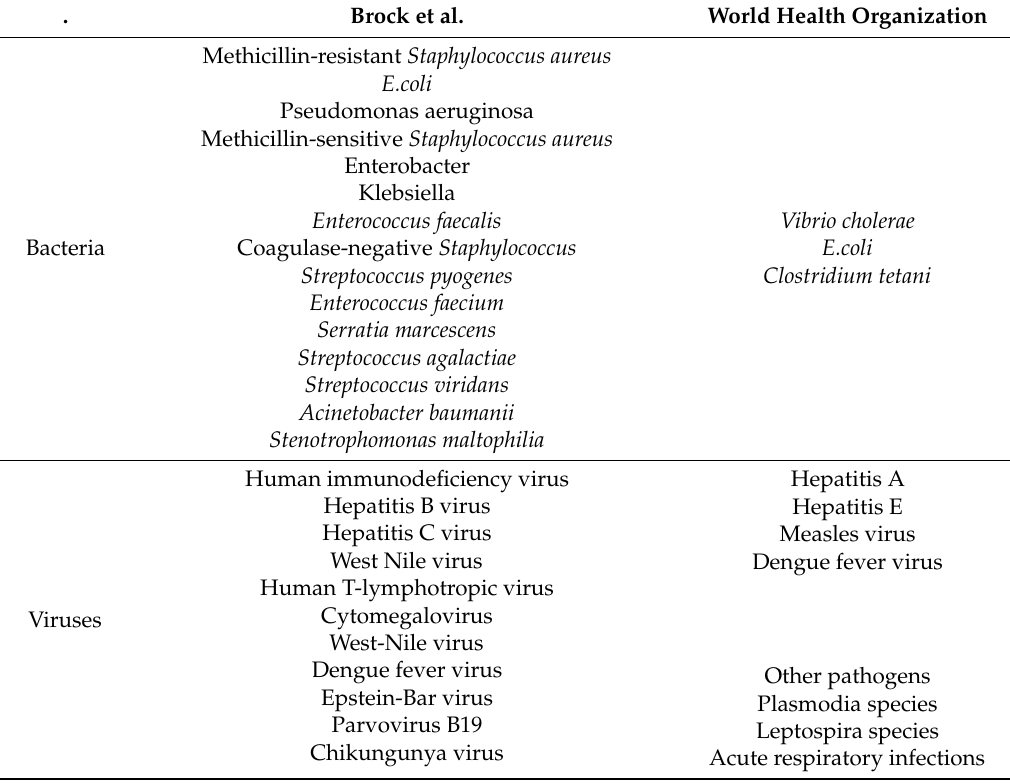
Table 2. Important Pathogens Related With Epidemic Outbreaks After Natural Disasters as Defined by Brock et al. [9] in Comparison to Pathogens Listed by the WHO [10].